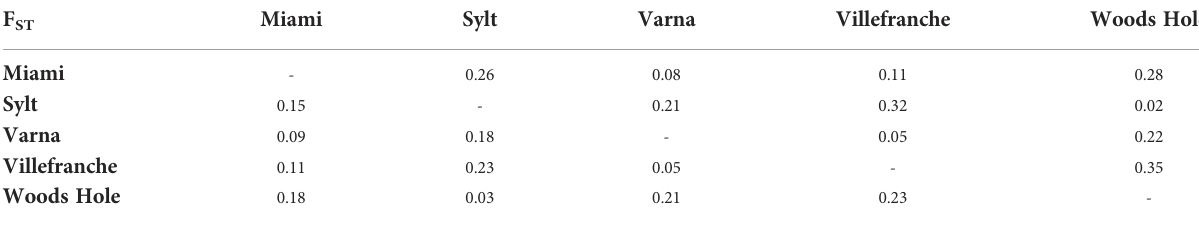
TABLE 1 Pairwise genetic differentiation (F ST ) between M. leidyi sampling locations at 116 SNPs (present study; lower diagonal) and at 832,323 SNPs (re-analysis of whole genome data using the same individuals; upper diagonal). F